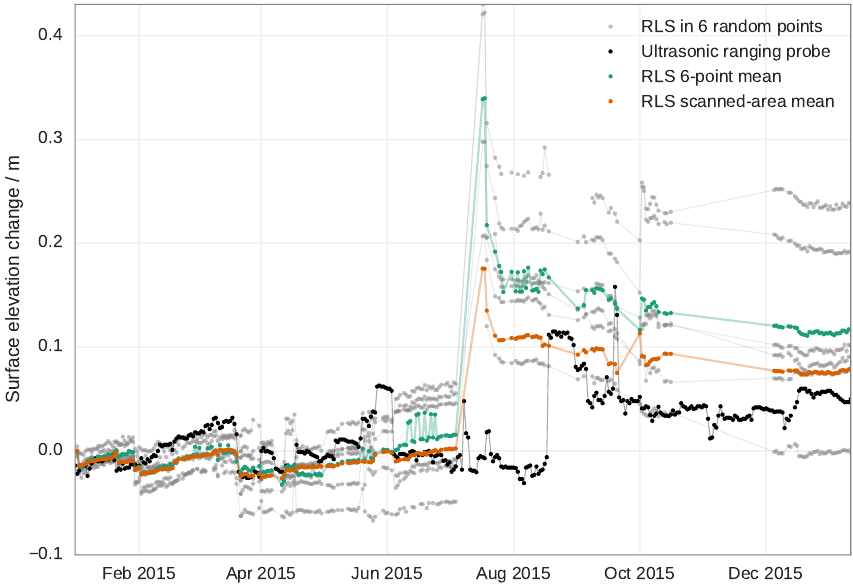
Figure 12. Evolution of the snow surface elevation change at Dome C taken in 6 random points in the scanned area (gray), on average over the 6 points (green), on average over the scanned area (orange) and measured by a nearby ultrasonic ranging probe